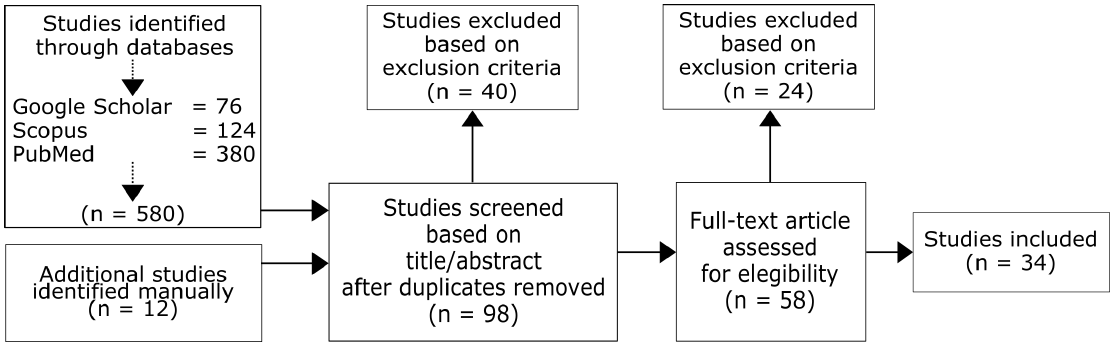
Figure 1. Flow diagram of the different phases of the systematic mapping